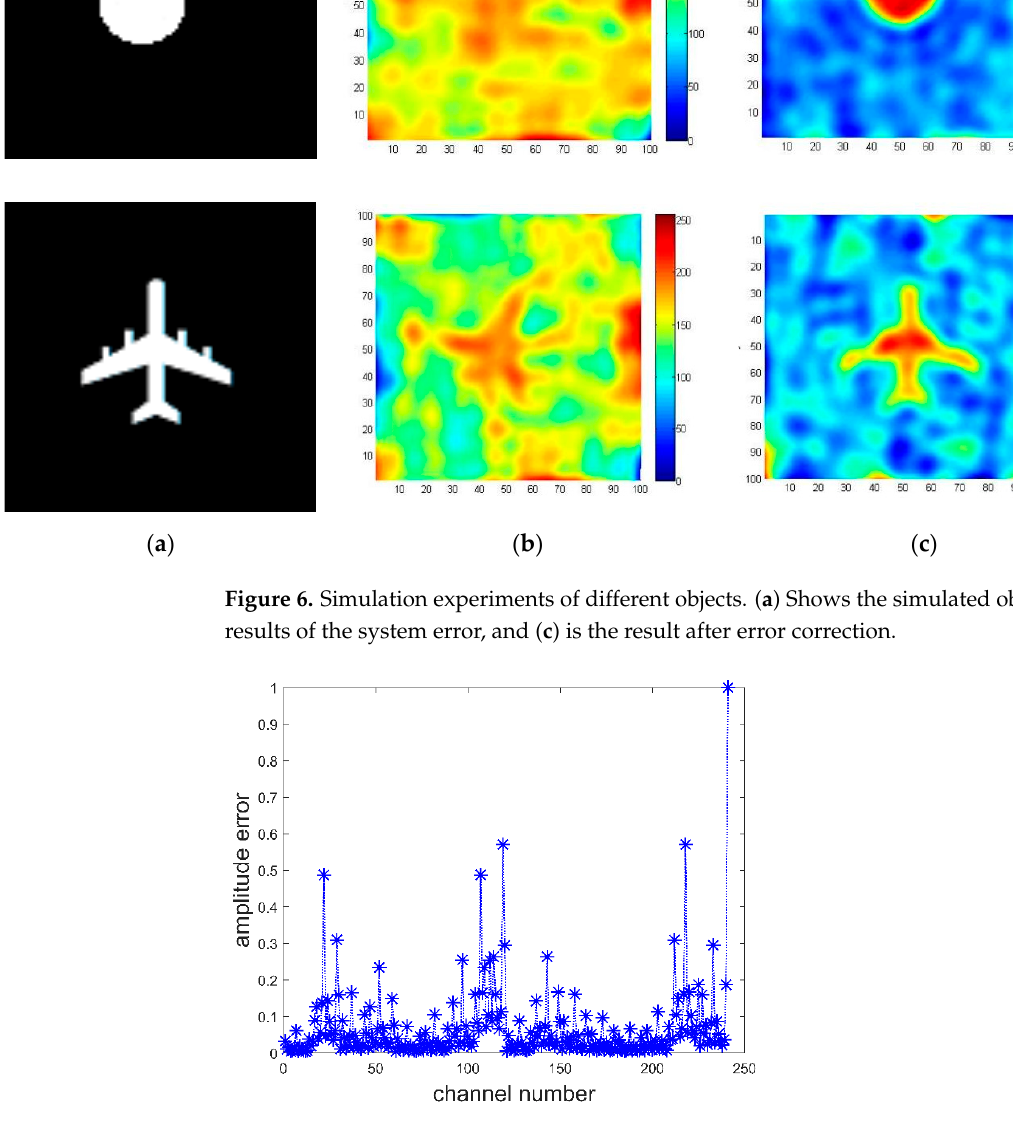
Figure 7. The channel amplitude imbalance error.